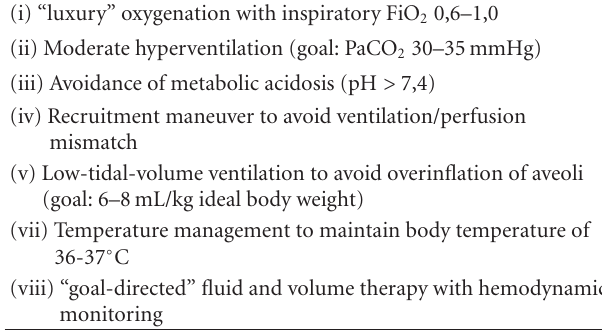
Table 10: Intraoperative “basic treatment” to avoid an increase of pulmonary arterial pressure (mod. [30, 31, 39, 48,